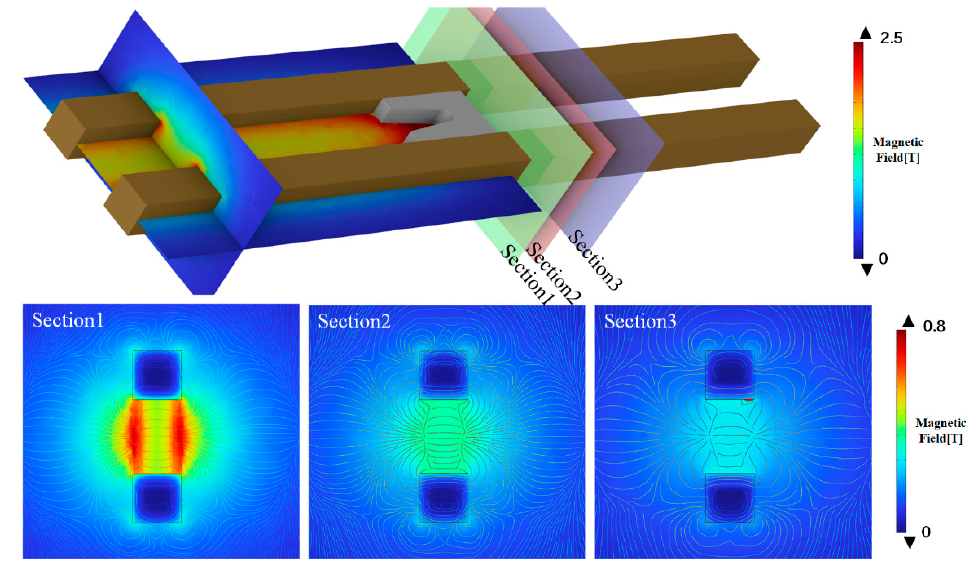
Figure 12. Magnetic field distribution at different positions in the bore of a traditional railgun.